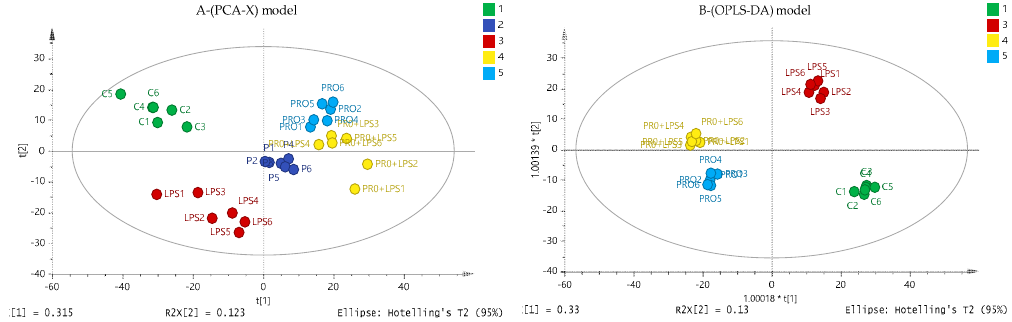
Figure 6. ( A ) PCA-X versus (B) OPLS-DA score plots of THP-1 cells. The figures show a clear separation between control, pooled and treatment groups (LPS, Propolis and Propolis + LPS) based on 403 polar metabolites separated on a ZIC-pHILIC column ( n = 6). The PCA score plot ( A ) gives R2X = 0.583, Q2 = 0.409. The OPLS-DA score plot ( B ) gives R2X = 0.640, R2Y = 0.984, Q2 = 0.753. (C: Control; Pro: Cameroonian propolis (P-C) propolis extract; LPS: Lipopolysaccharides; Pro + LPS: Propolis and LPS ( = P-C + LPS) combination treatments; P = pooled samples). PCA: Principle component analysis.